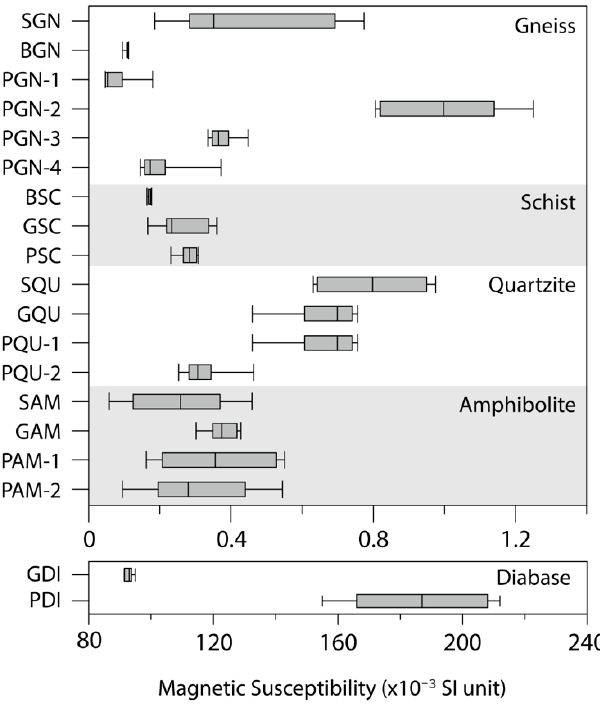
Figure 4. Diagram showing magnetic susceptibility distributions by rock type. Sample names are the same as those in Table 1.